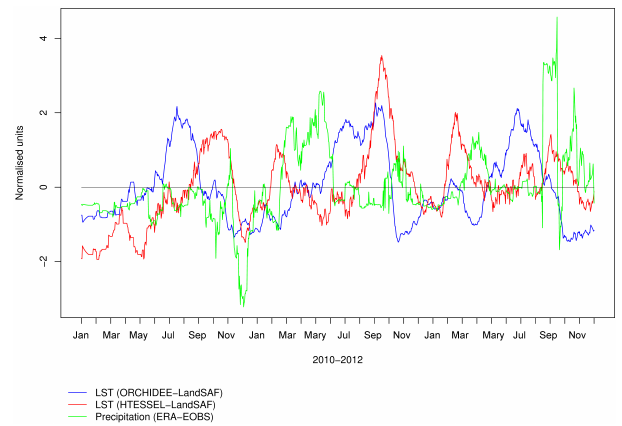
Figure 8. Temporal evolution of the expansion coefficients corre- sponding to the first EOF variation mode of the LST and the precip- itation errors. As in Fig. 5, values have been normalized using the standardization